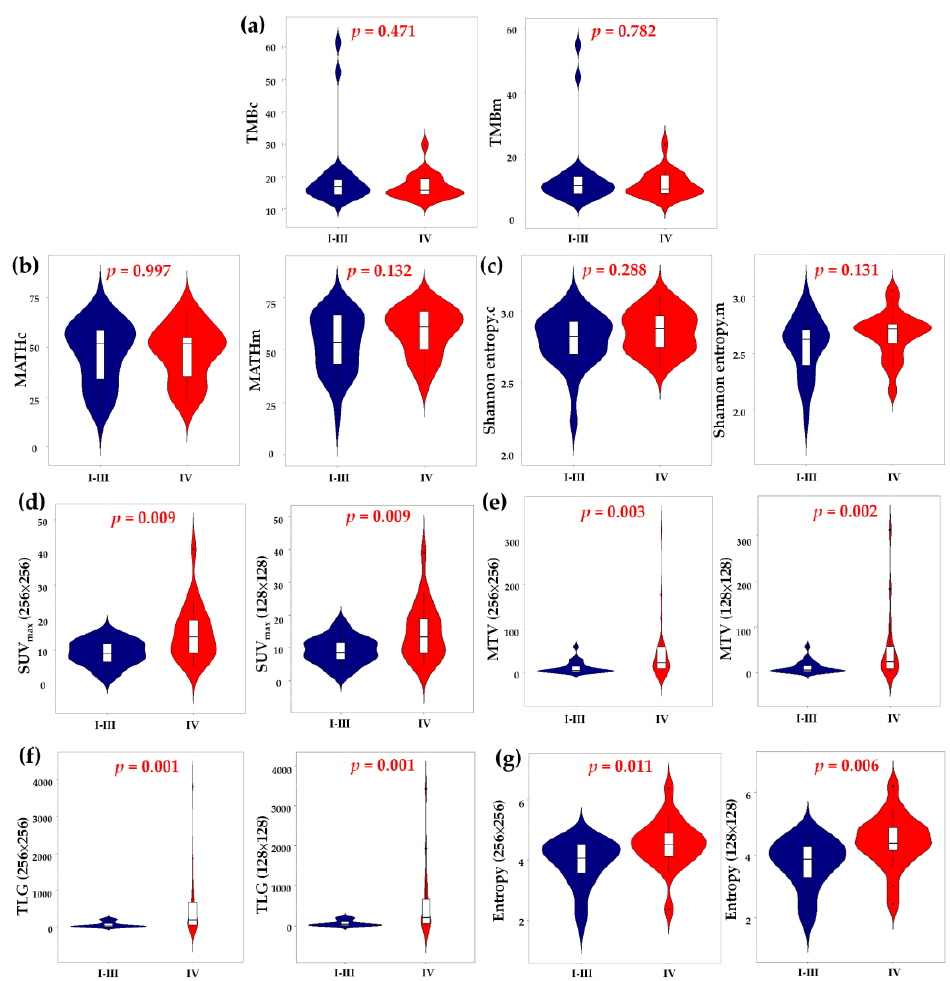
Figure 3. Comparing the TMB ( a ), MATH ( b ), Shannon entropy ( c ), SUV max ( d ), MTV ( e ), TLG ( f ) and entropy ( g ) between patients with cancer stages of I to III and IV. TMB, tumor mutation burden; MATH, mutant-allele tumor heterogeneity; SUV, standardized uptake value; MTV, metabolic tumor volume; TLG, total lesion